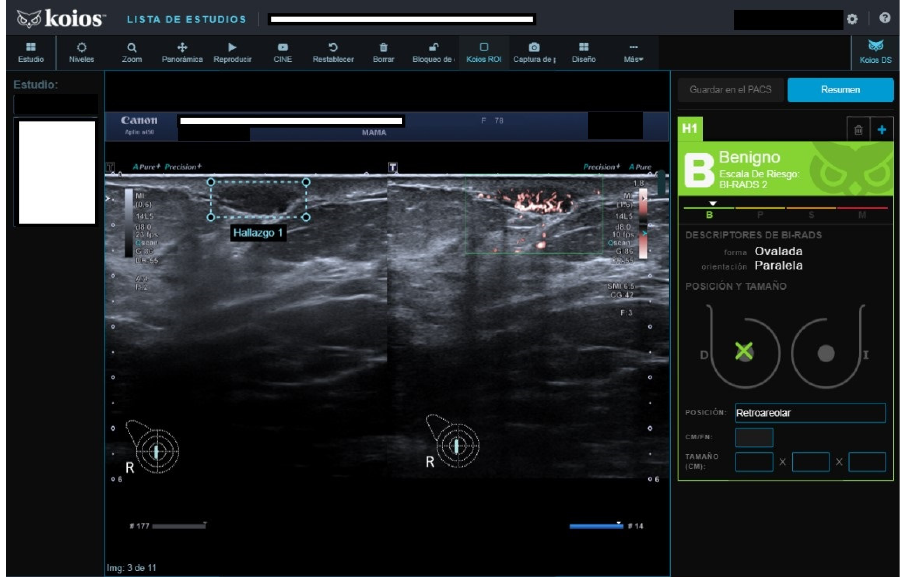
Figure 5. New nodule in right breast with previous carcinoma 25 years before. Rated B4a, Kbe by KOIOS. Surgery rendered a malignant fibrous histiocytoma. There were 101 B4b category cases, 42 with malignant results. KOIOS reported seven benign and eleven probably benign cases; only one of the benign and two of the probably benign had a false negative result (Figure 6). There were 29 benign and 19 malignant KSS cases. The KPM cases numbered 35 and only 20 had a malignant pathology diagnosis.